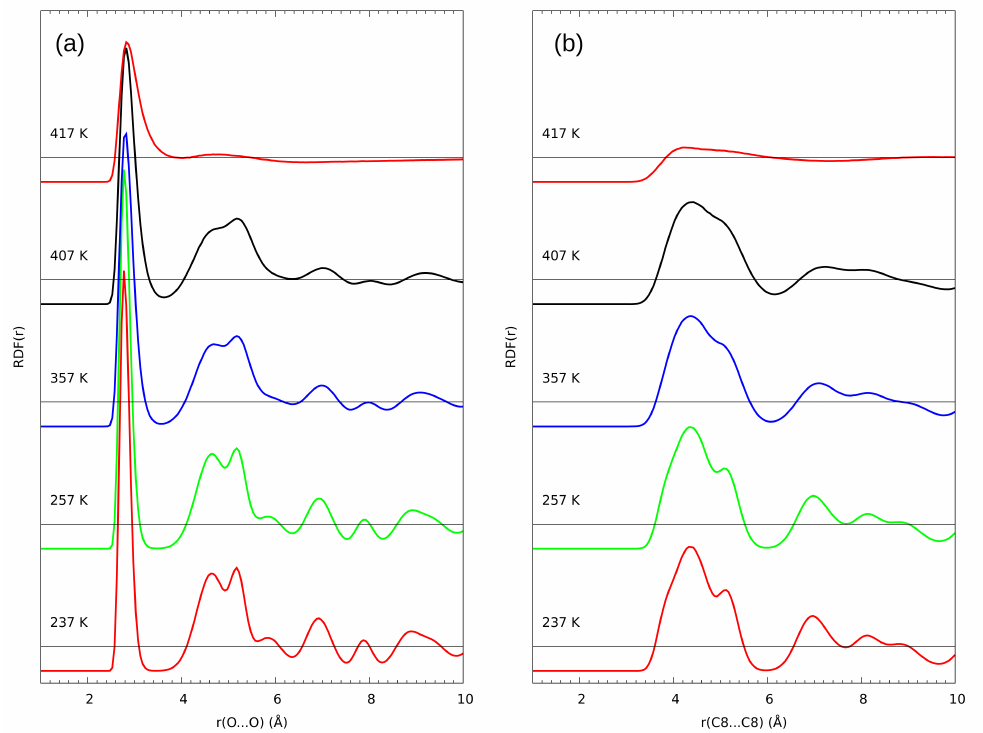
Figure 7. Temperature dependence of radial distribution functions (RDF) for ( a ) O–O and ( b ) C8–C8 atom pairs. Results of classical MD simulations of n-octanol in five selected temperatures.